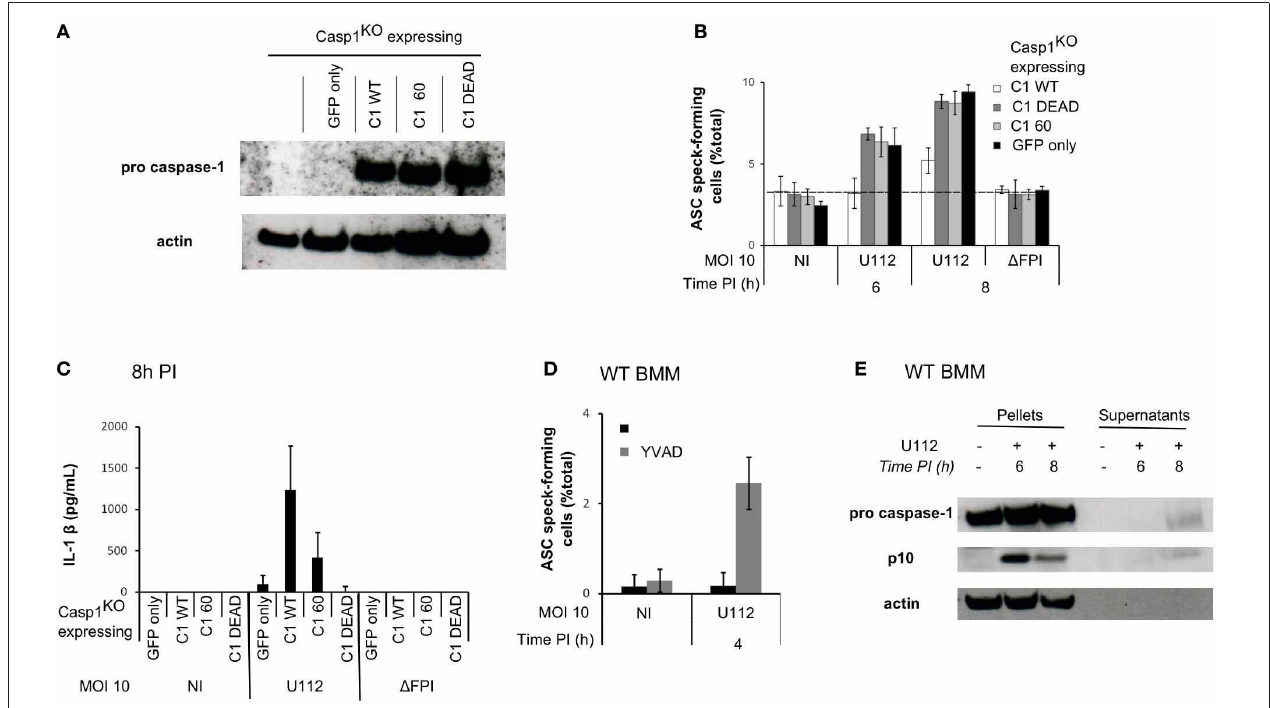
FIGURE 5 | Sublytic caspase-1 activity and processing are required to regulate ASC complex formation during F. novicida infection. (A–C) Casp1 KO myeloid progenitors were transduced with constructs encoding the following proteins: Casp1 WT , Casp1 DEAD (catalytic mutant), C60 (autoproteolytic mutant) or GFP only. (A) Immunoblots for caspase-1 p20 and β -actin show similar level of caspase-1 expression in macrophages transduced with the different caspase-1-encoding constructs. (B) Following transduction and differentiation in macrophages, cells were sorted based on GFP-expression and infected with F. novicida at a MOI of 10:1. ASC